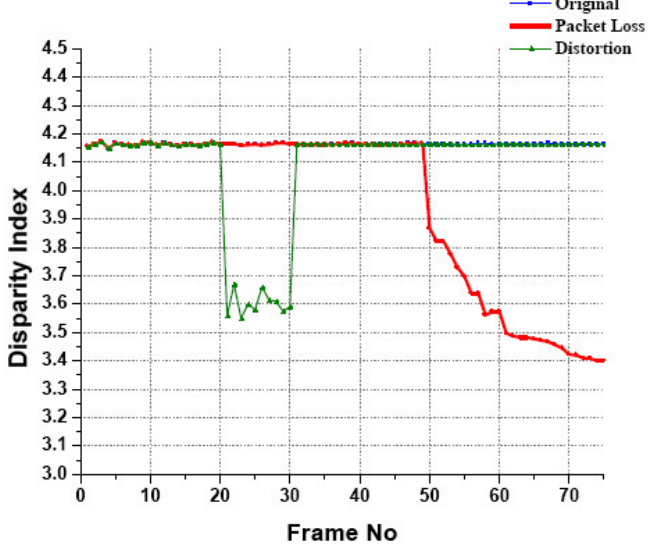
Figure 8. Disparity indices with respect to frames for the Bicycle Riding 3D